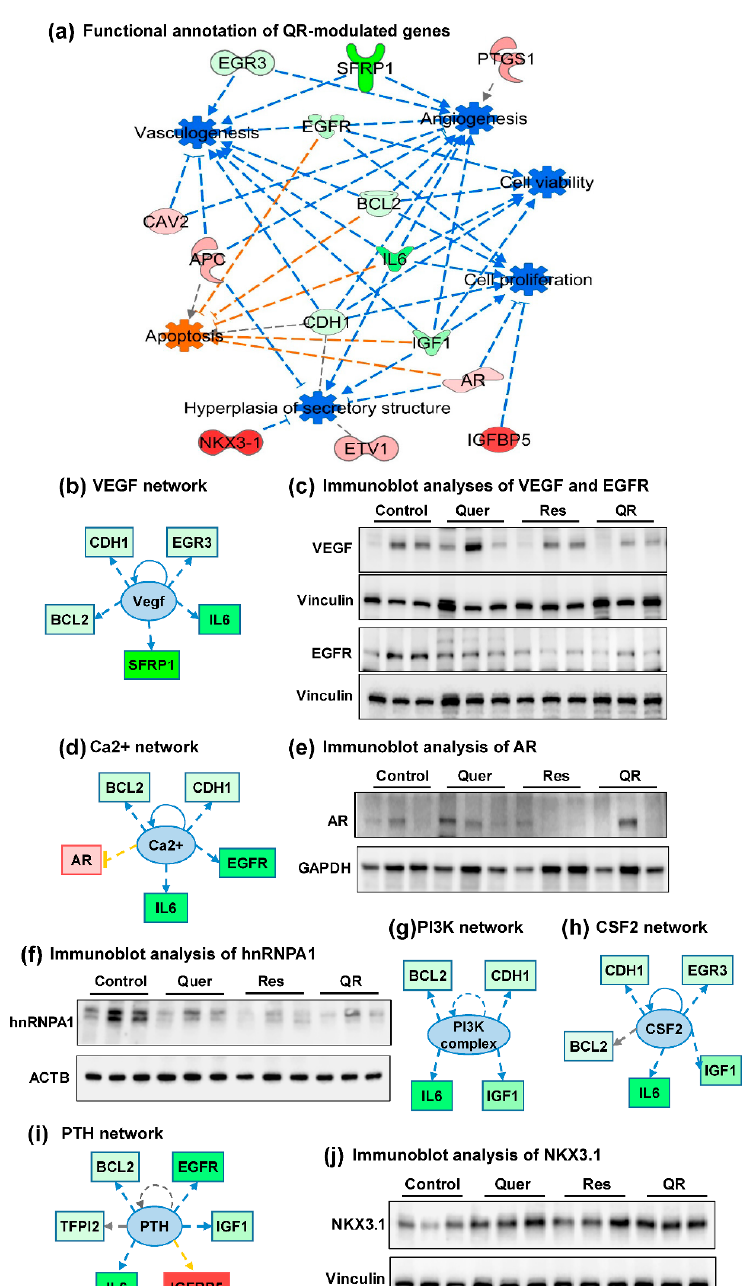
Figure 6. Analysis of quercetin–resveratrol (QR)-modulated genes suggest cumulative antitumor actions and upstream inhibition of major PCa signaling pathways. ( a ) Functional annotation showing cumulative actions of QR-modulated genes: increased apoptosis and inhibition of cell viability/ proliferation, hyperplasia, vasculogenesis, and angiogenesis. ( b,d,g – i ) Using IPA, upstream regulator analysis identified genes potentially involved in changes seen in RT-qPCR analyses. Genes from array are in red (upregulated) and green (downregulated), while predicted functions and upstream regulator genes and interaction lines are in orange (activation) and blue (inhibition). Lines in yellow indicate findings inconsistent with the state of downstream molecules. The gray dotted line shows unpredicted effects. Immunoblot analyses of ( c ) vascular endothelial growth factor (VEGF) and epidermal growth factor receptor (EGFR), ( e ) androgen receptor (AR), ( f ) hnRNPA1, and ( j ) NKX3.1 proteins. Vinculin, ACTB, and GAPDH were used as loading controls.